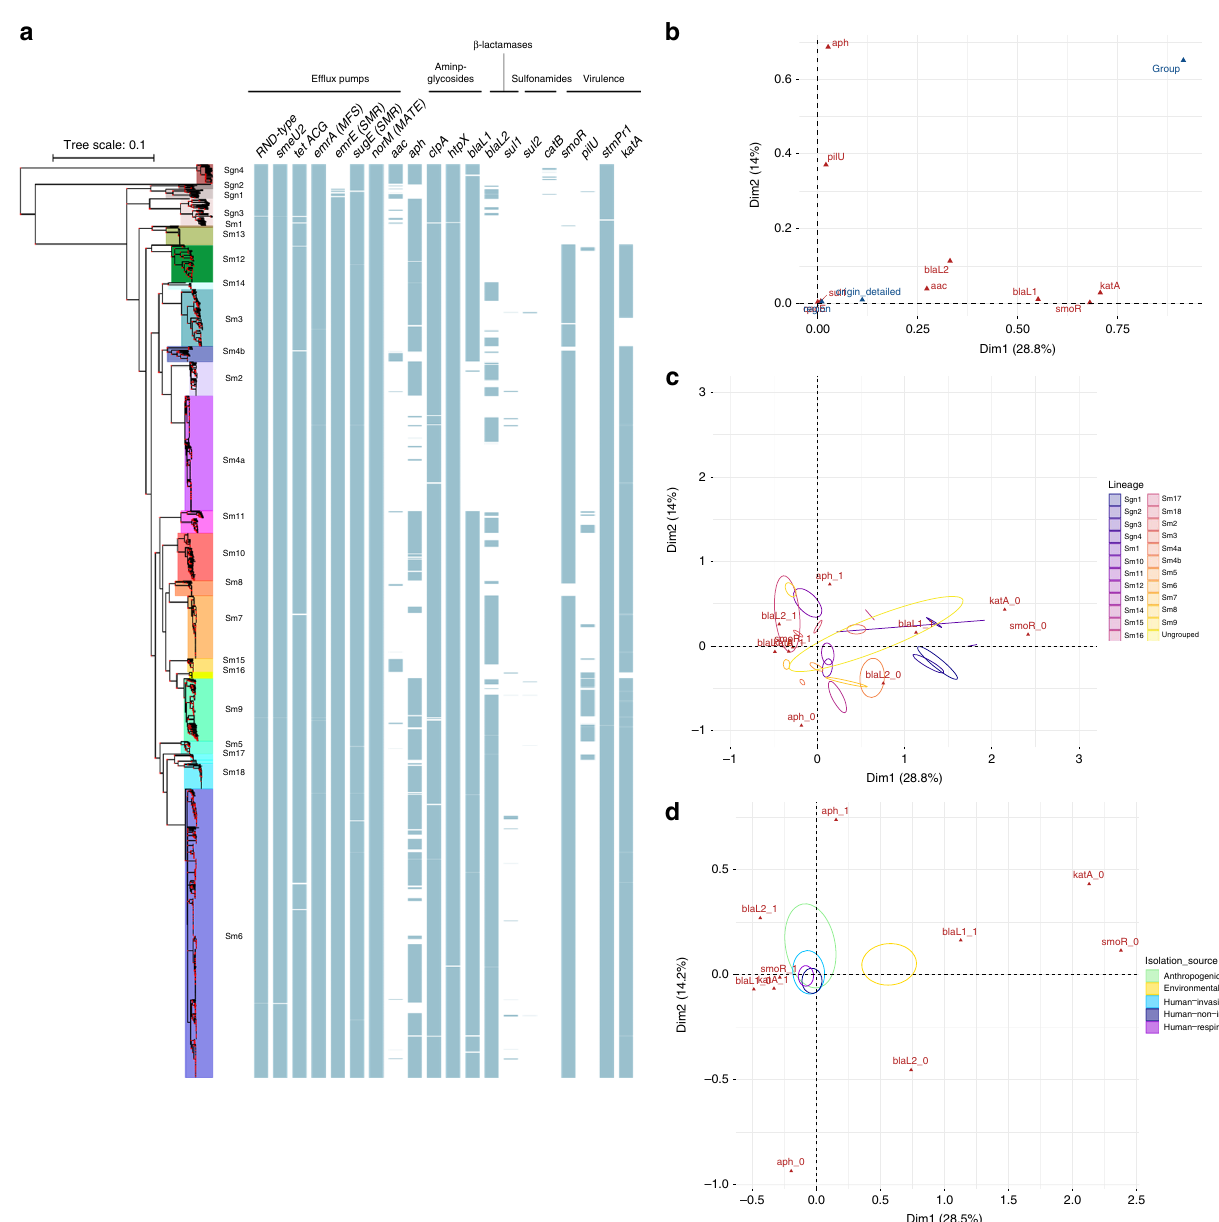
Fig. 3 Resistance and virulence gene analysis. a Midpoint rooted maximum likelihood phylogenetic tree based on 1275 core gene sequences of 1305 S. maltophilia complex strains. The coloured shading of the lineages represents the groups found by Bayesian clustering, with lineage names given. Hundred percent branch support is indicated by red dots. The pattern of gene presence (blue coloured line) or absence (white) is displayed in columns next to the tree, showing, from left to right, selected ef fl ux pump genes: resistance-nodulation-cell-division (RND)-type ef fl ux pumps, smeU2 as part of the fi ve-gene RND ef fl ux pump operon smeU1-V-W-U2-X , tetACG , emrA of the major facilitator superfamily (MFS), emrE and sugE of the small-multidrug-resistance (SMR) ef fl ux pump family, norM of the MATE family; the aminoglycoside acetyltransferase aac and phosphotransferase aph , clpA , htpX , the β -lactamases blaL1 and blaL2 , the sul1 and sul2 genes encoding dihydropteroate synthases, catB , and the virulence genes smoR , pilU , stmPr1 and katA . b Variable correlation plot of a multiple correspondence analysis (MCA) visualising nine resistance and virulence genes as active variables in red and three supplementary variables region, origin and groupin blue. c Factor individual biplot map of phylogenetic lineages, indicated by their 99% con fi dence intervals (ellipses) across the fi rst two MCA dimensions. The fi ve highest contributing active variables are shown in red with 0 denoting absence and 1 presence of this variable. d Factor individual biplot map of the isolation source as indicated in the coloured legend. Source data are provided as Source Data fi